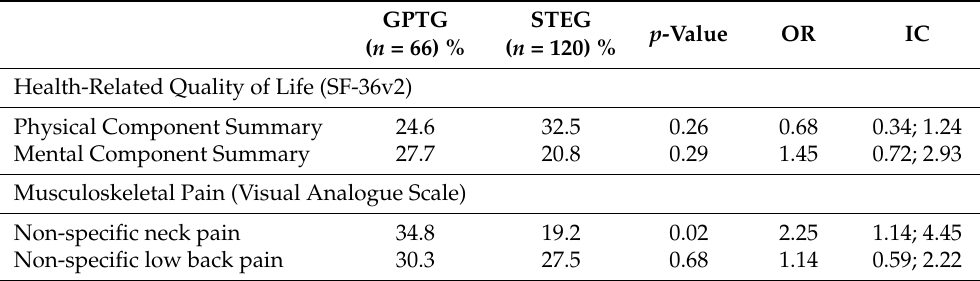
Table 6. Clinical effectiveness by intervention